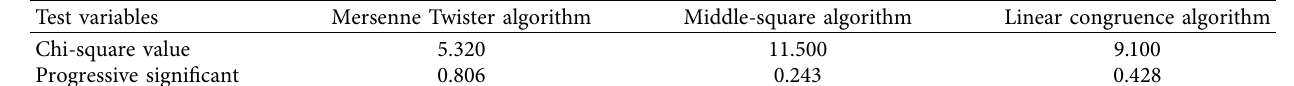
Table 2: Comparison of uniformity test indices of three